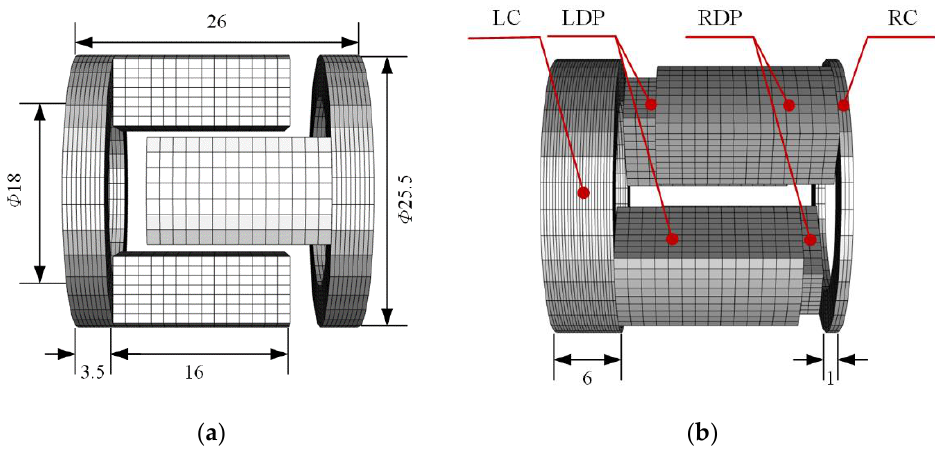
Figure 4. Grid models of ( a ) the left pump unit and ( b ) the right pump unit.